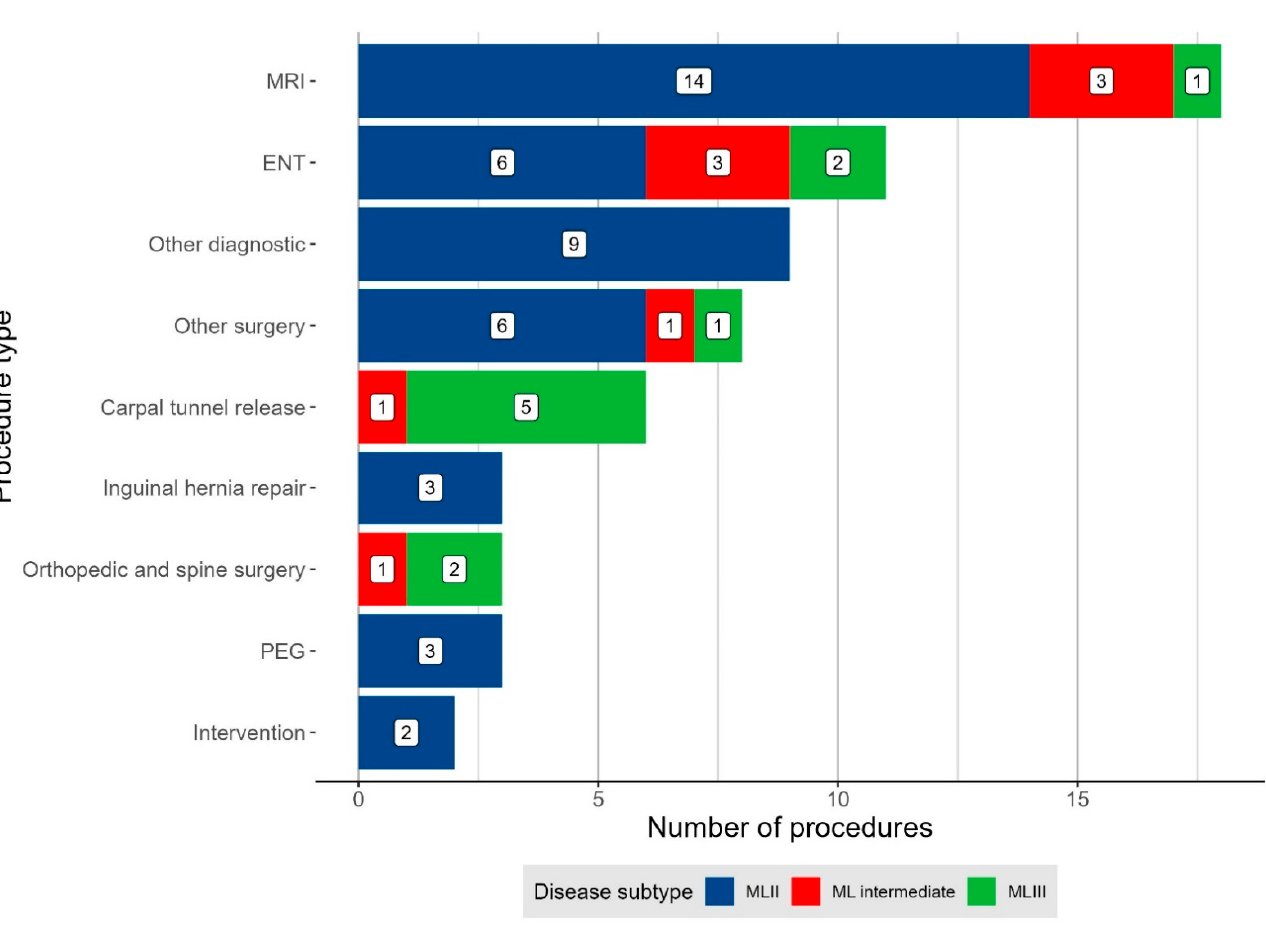
Figure 2. Indication for anaesthesia in all cases of patients with mucolipidosis. “Other diagnostic” sums up brainstem evoked response audiometry (BERA), ophthalmological, and neurophysiological assessments. “Other surgery” denotes all surgeries not represented in any other category and includes gingivectomy, dental, cardiac, and oncologic surgeries, and “intervention” indicates one lumbar puncture and one skin biopsy. Abbreviation: ENT, ear, nose, and throat surgery; MRI, magnetic resonance imaging; PEG, percutaneous endoscopic gastrostomy placement or exchange. Table 3. Anaesthesia-related complications subdivided by ML